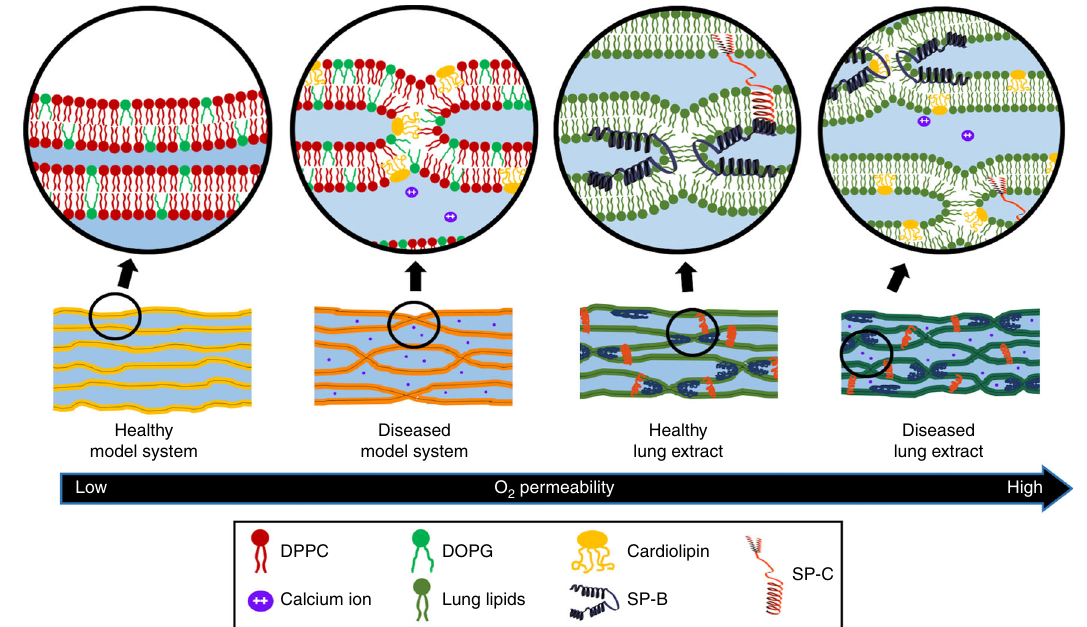
Fig. 6 Mechanism of enhanced oxygen gas transport through stalk phases. Schematic illustrations of model systems and lung extracts in healthy and diseased states and how their different structures affect oxygen gas permeability. Enlarged illustrations (circles) describe detailed structures of each system, displaying lipids (e.g., DPPC, DOPG, Cardiolipin, and BLES), surfactant proteins (SP-B and SP-C) and calcium